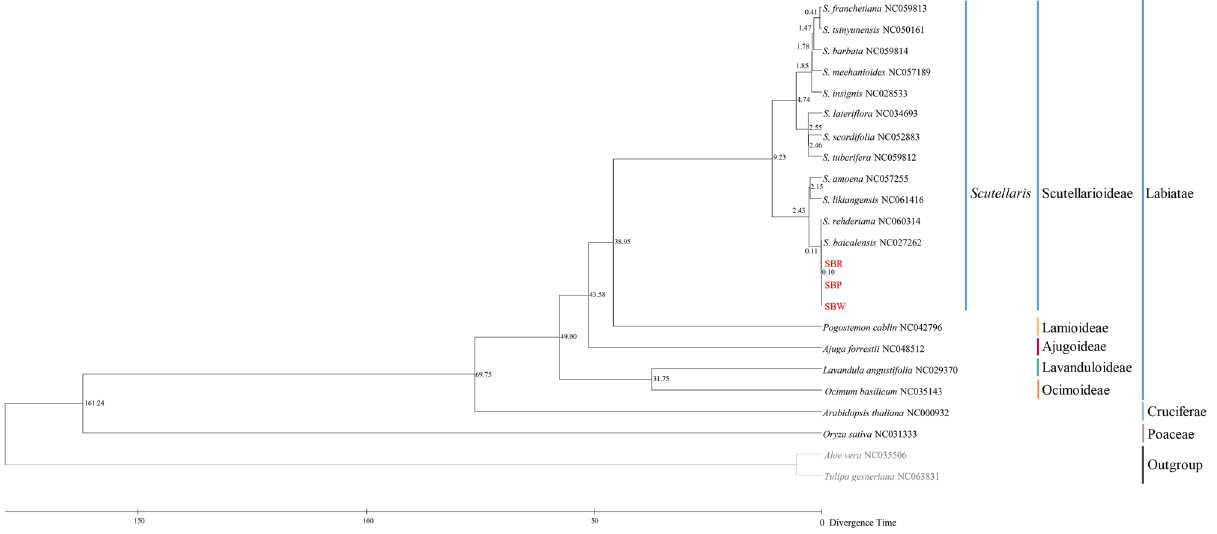
Figure 10. Divergence times tree obtained from a molecules clock analysis using the MEGA software. The node ages are given for each